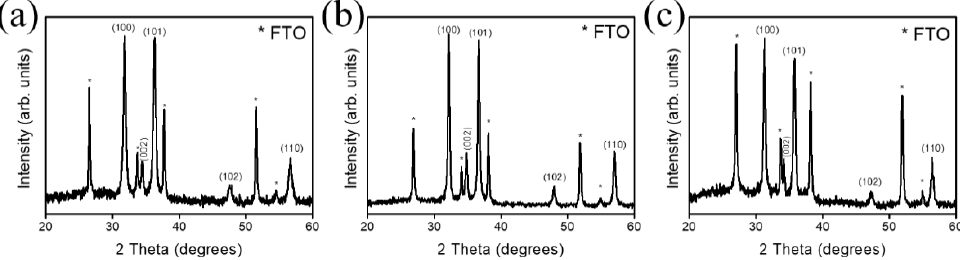
Figure 2. XRD patterns of various ZnO sheets: ( a ) ZnO. ( b ) ZnO-A. ( c ) ZnO-H. The asterisk denoted the Bragg reflections from the F-doped tin oxide (FTO).